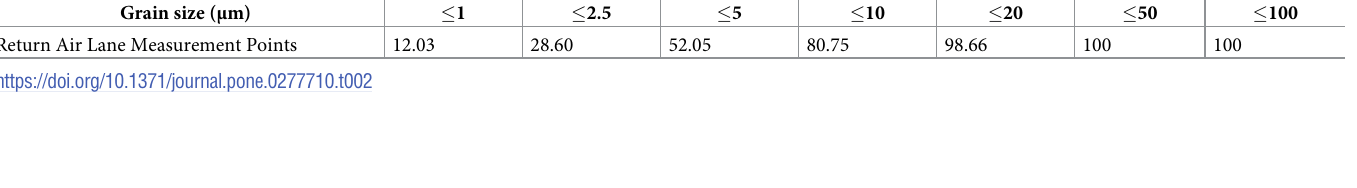
Table 2. Measured coal dust dispersion data (%) at the East Wing 00 working face of Mindong I Mine. Grain size ( μ